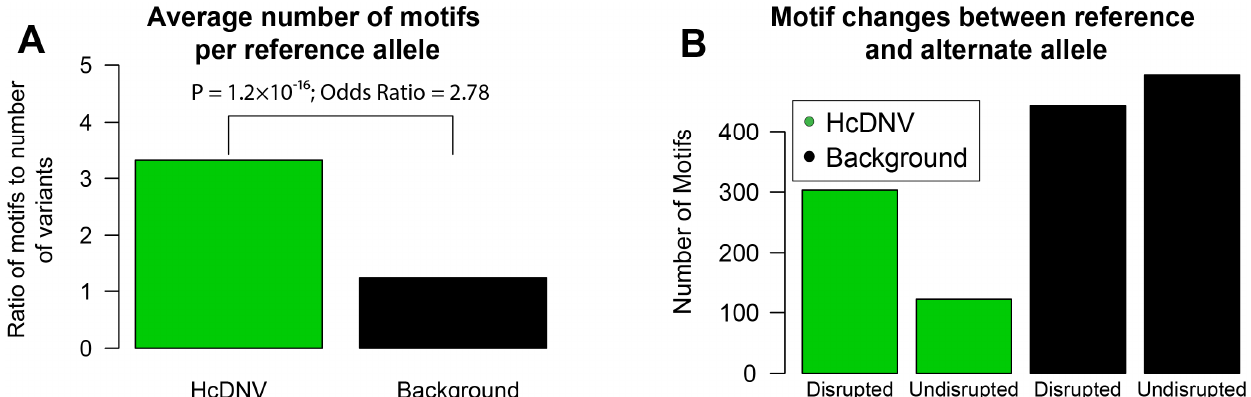
Figure 4. Transcription factor binding motif disruption in HcDNV variants. Fimo was used to call transcription factor binding motifs that overlapped with the variant position. Fisher’s exact test was used to find the p -value and odds ratio for the proportions in ( A , B ). ( A ) Barplot showing the ratio of the number of filtered motifs found over the number of variant sequences used to find overlapping motifs. ( B ) Barplot showing the number of filtered motifs for HcDNV and background variants separated into those that are found only with the reference allele version of the CRS and not the alternate allele version (Disrupted), and motifs that are found in both the reference and alternate forms of the CRS (Undisrupted). Fisher’s exact test p -value: 4.9 × 10 − 30 , Odds Ratio: 2.68.